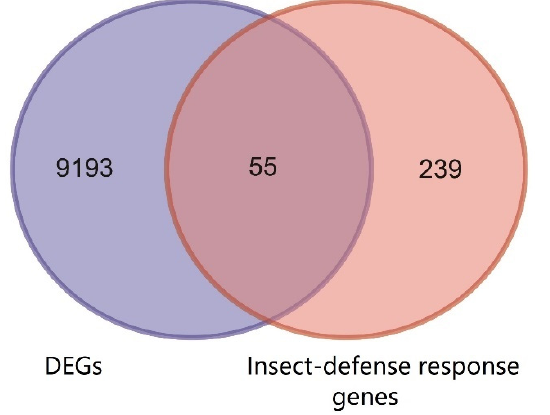
Figure 3. Venn diagram representing the number of total DEGs and insect-defense response genes in Z. bungeanum .